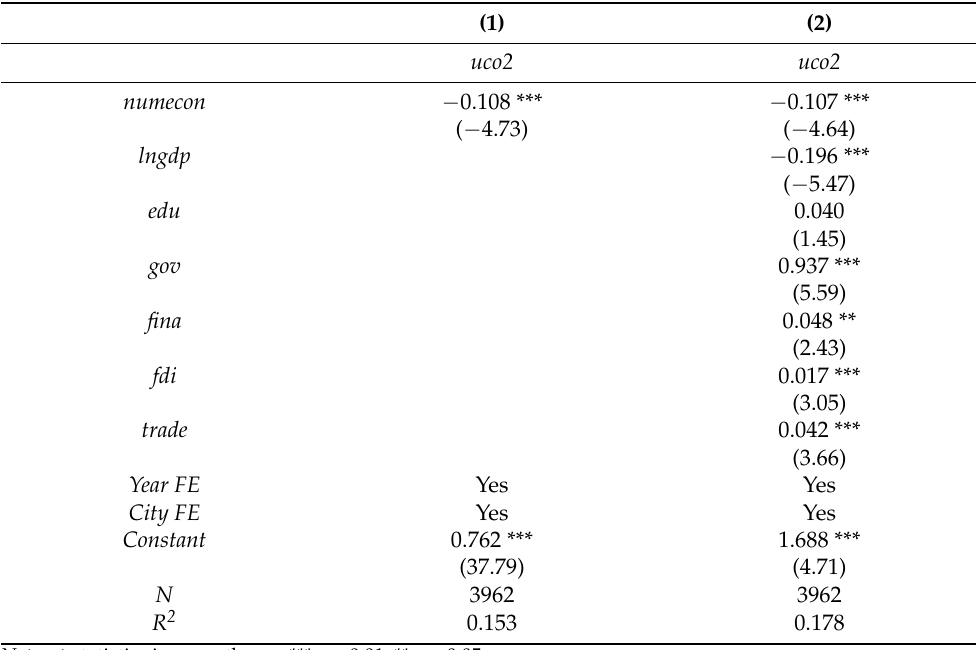
Table 2. Baseline regression